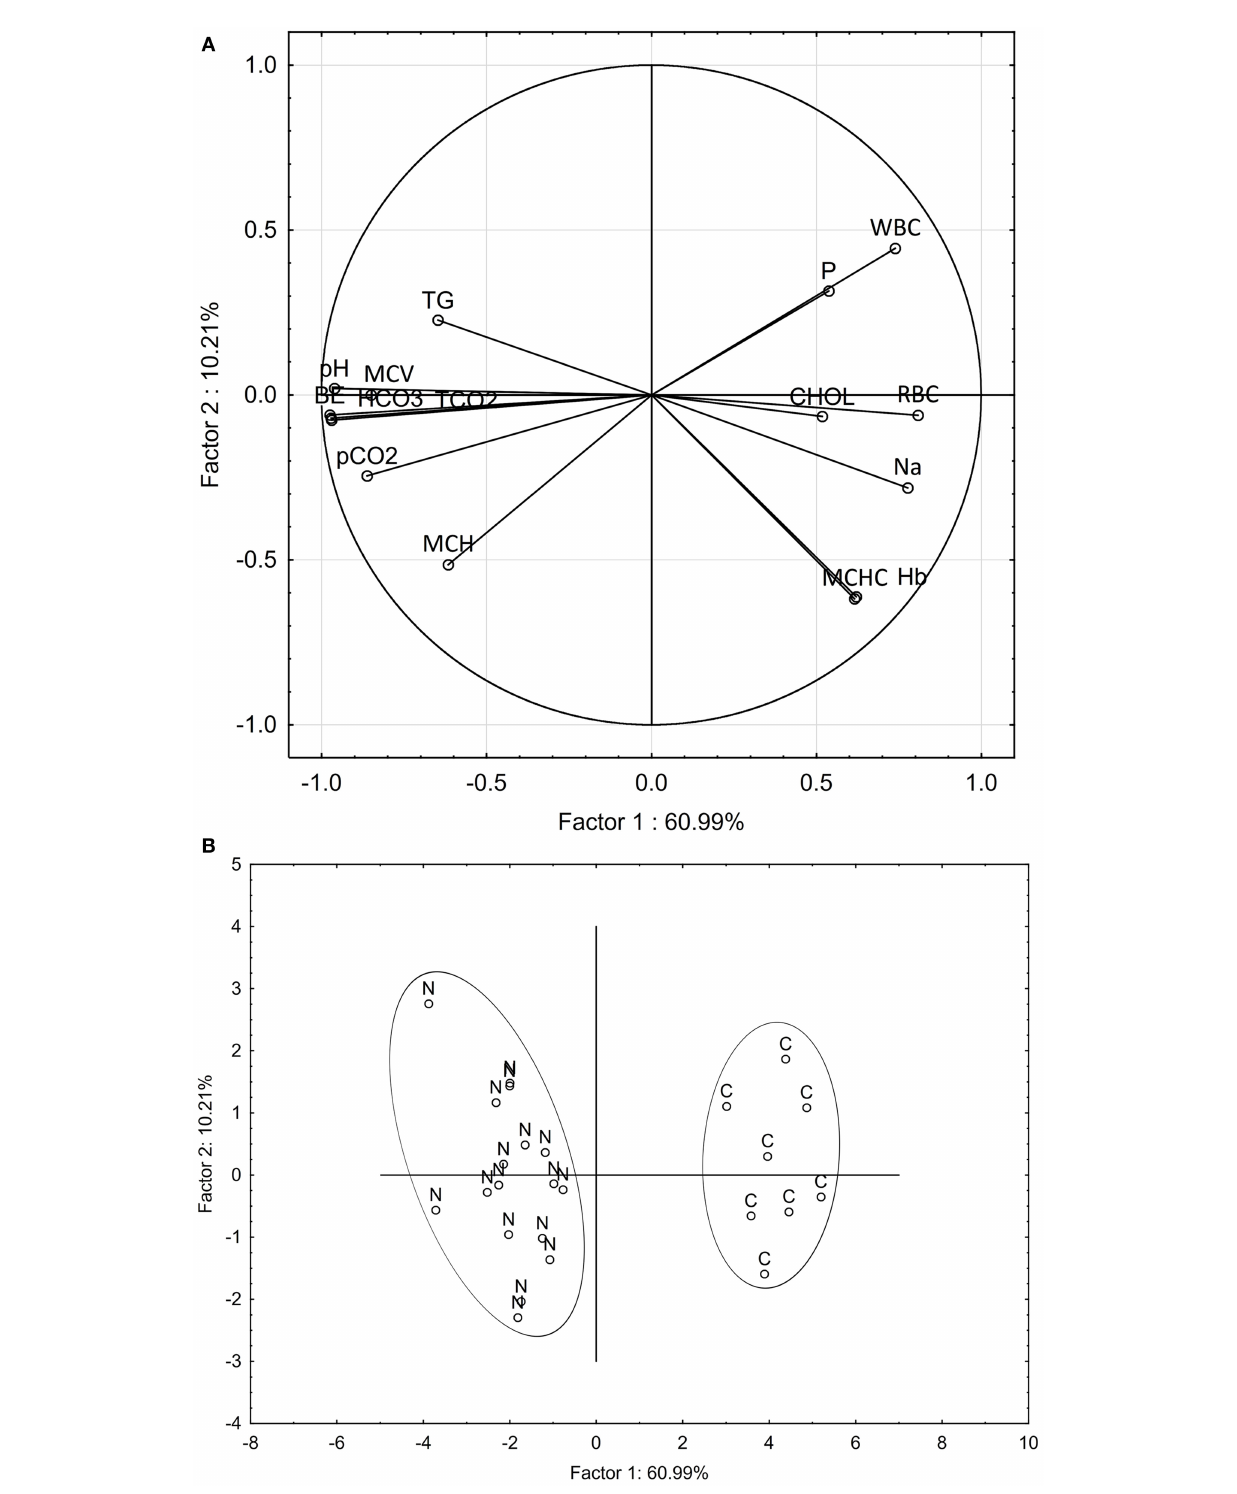
FIGURE2 Principal component analysis discriminating between nephrocalcinosis (N)-affected and healthy (C) fish ( Oncorhynchus mykiss ), based on all blood profile parameters detected as altered using univariate analysis. Component weight (A) and component score (B) plots are based on multiple blood chemistry and hematology variables. BE, base excess; CHOL, cholesterol; Hb, hemoglobin; HCO 3 , bicarbonate; MCH, mean corpuscular hemoglobin; MCHC, mean corpuscular hemoglobin concentration; MCV, mean corpuscular volume; Na, sodium; P, phosphorus; pCO 2 , partial pressure of carbon dioxide; pH, potential of hydrogen; RBC, red blood cell count; WBC, white blood cell count; tCO 2 , total dissolved CO 2 ; TG,